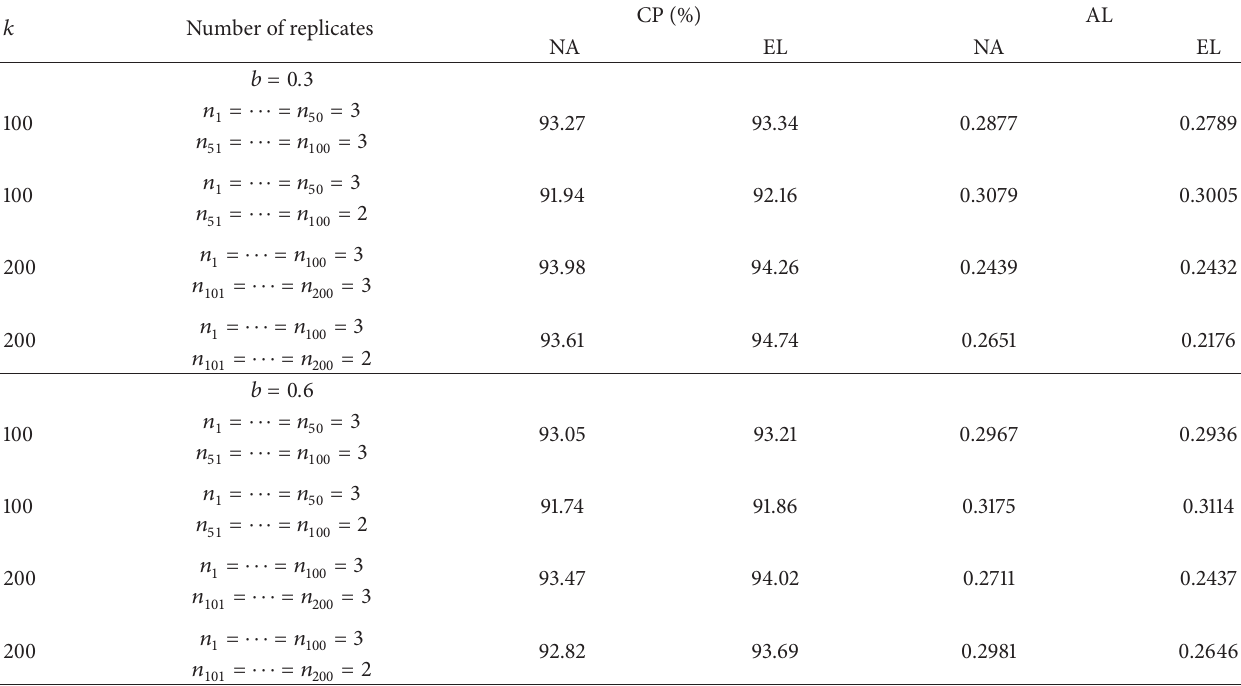
Table 1: Coverage probabilities (CP) and average lengths (AL) of the confidence intervals for 𝛽 = 1.5 and 𝜎 2 = 0.2 .